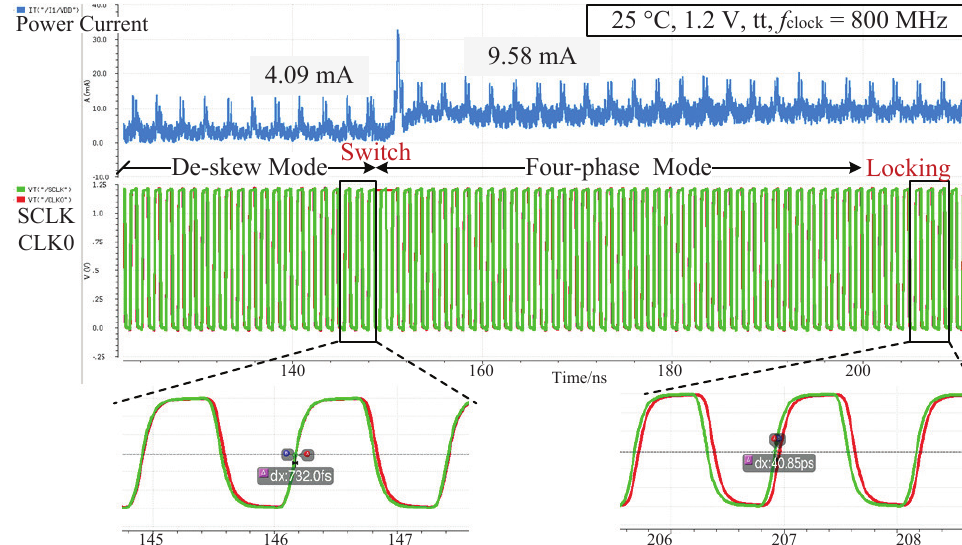
Figure 9. The power current and alignment error in serial-cascaded configuration.